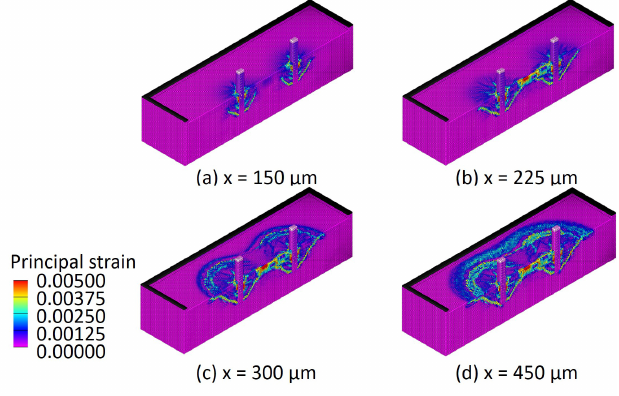
Figure 21. Crack development when the spacing s is 150 mm.